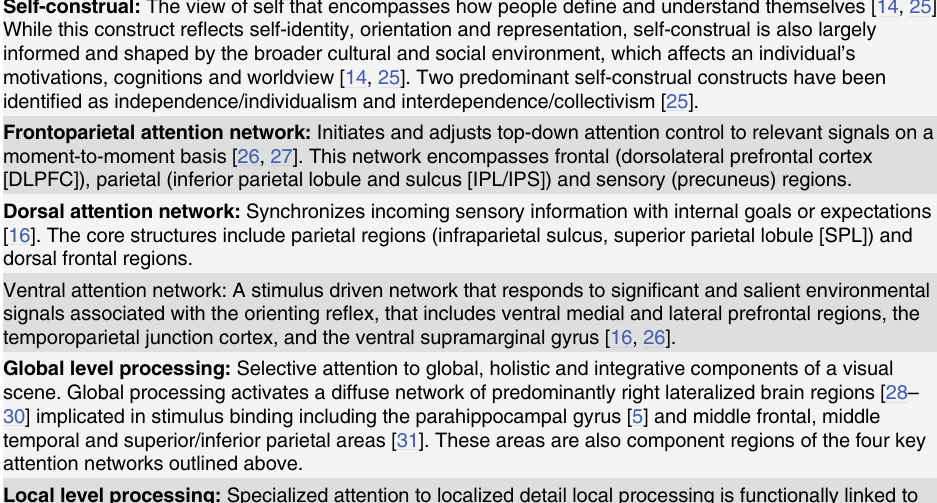
Table 1. Definitions of cultural value, attention networks and hierarchical visual processing